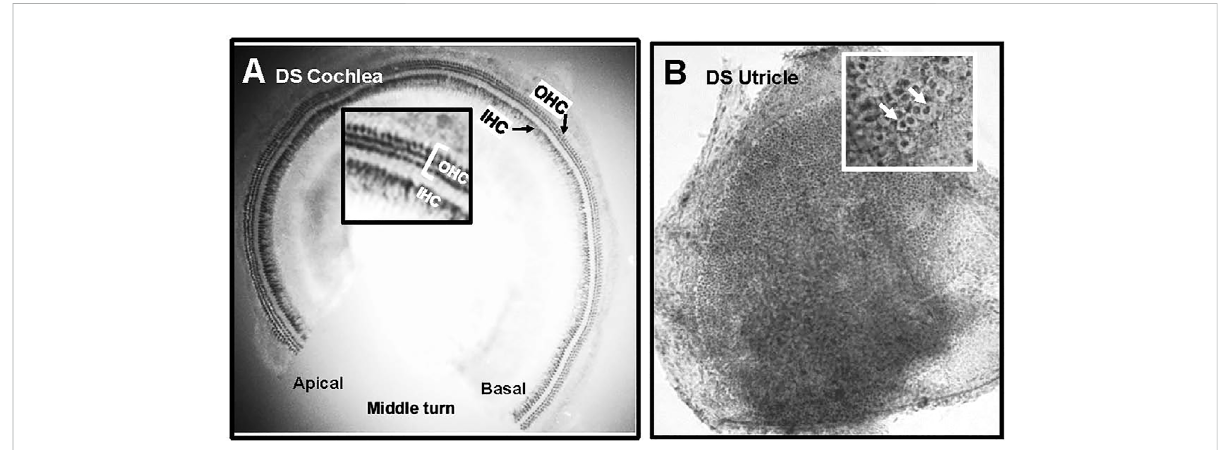
FIGURE 6 Normal population of hair cells in sensory epithelium of the cochlea and vestibular system of Down syndrome (DS) mice. Representative photomicrographs of (A) middle turn of DS mouse cochlea stained with succinate dehydrogenase. Three rows of outer hair cells (OHCs) and single row of inner hair cells (IHCs) spiral from the basal toward the apical region of the cochlea. Inset shows higher magni fi cation view of three rows of OHCs and row of IHCs. (B) Representative photomicrograph of macula of utricle stained with Harris hematoxylin. Macula densely packed with vestibular hair cells. Inset shows higher magni fi cation view of darkly stained hair cells surrounded by translucent chalice surrounding afferent nerve fi bers